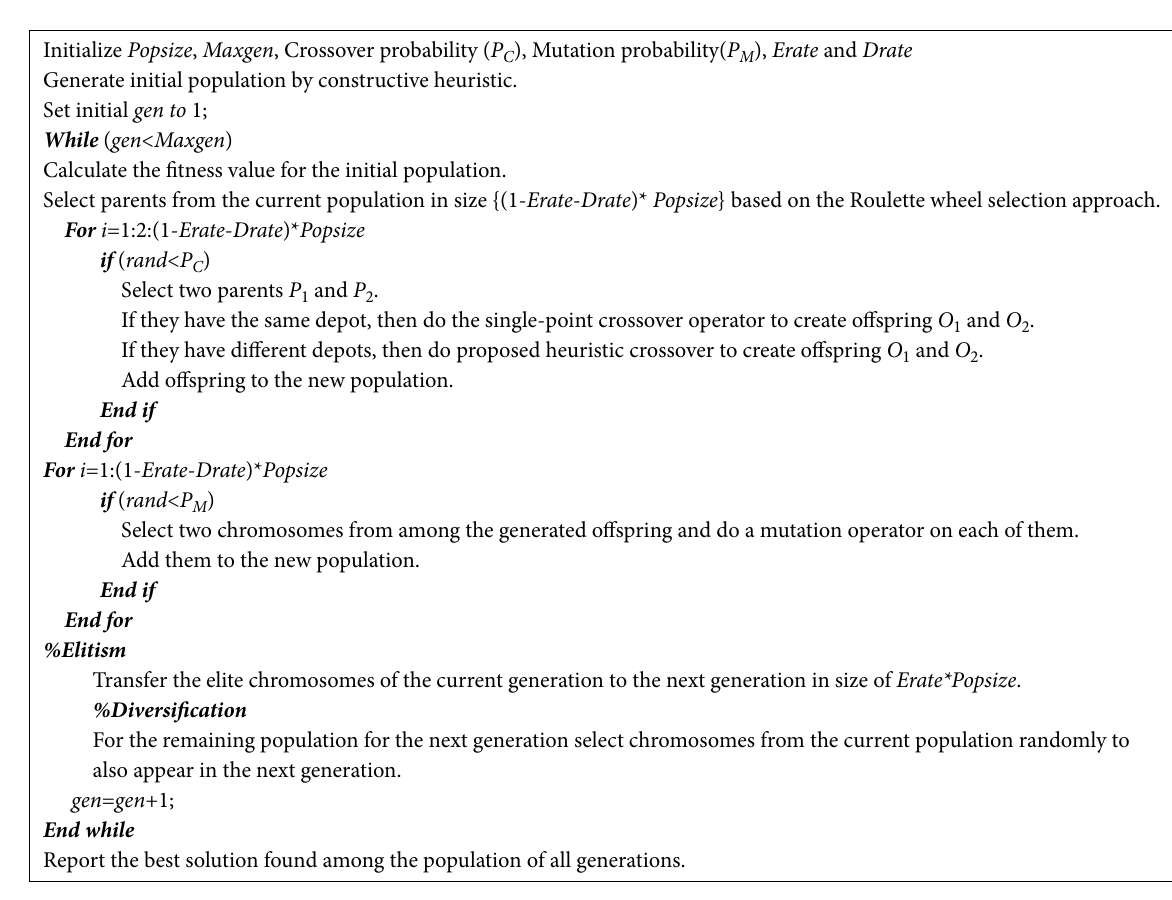
Figure 5. Pseudocode of the proposed